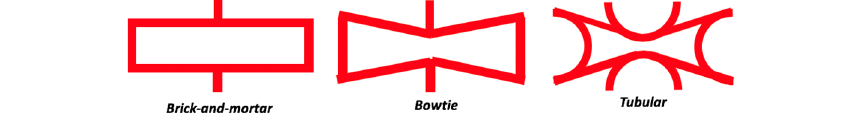
Figure 6. Typical unit cells of polymeric reinforcement used in the study by Rosewitz et al.[28]. Note that horizontal orientation of unit cells is shown, while other orientations were also